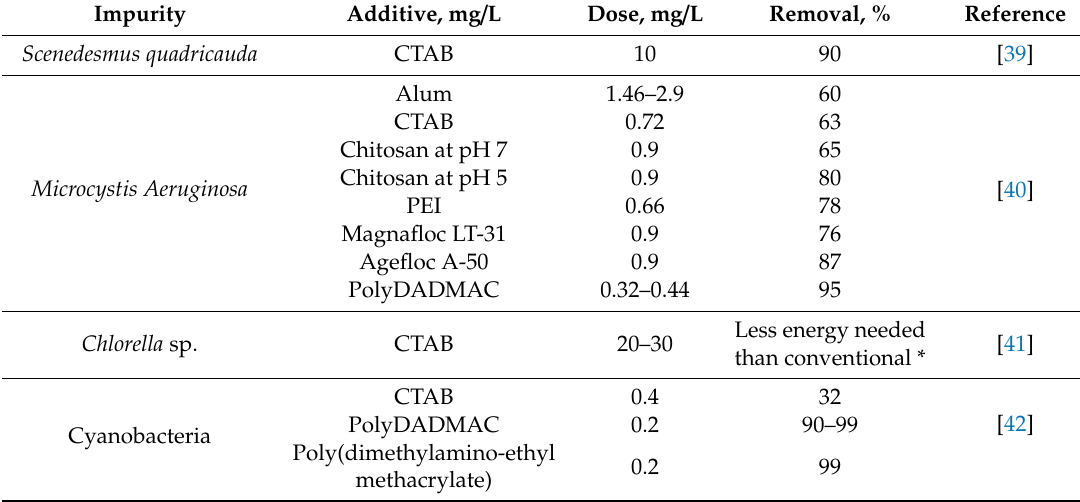
Table 3. Removal of algae by dissolved air